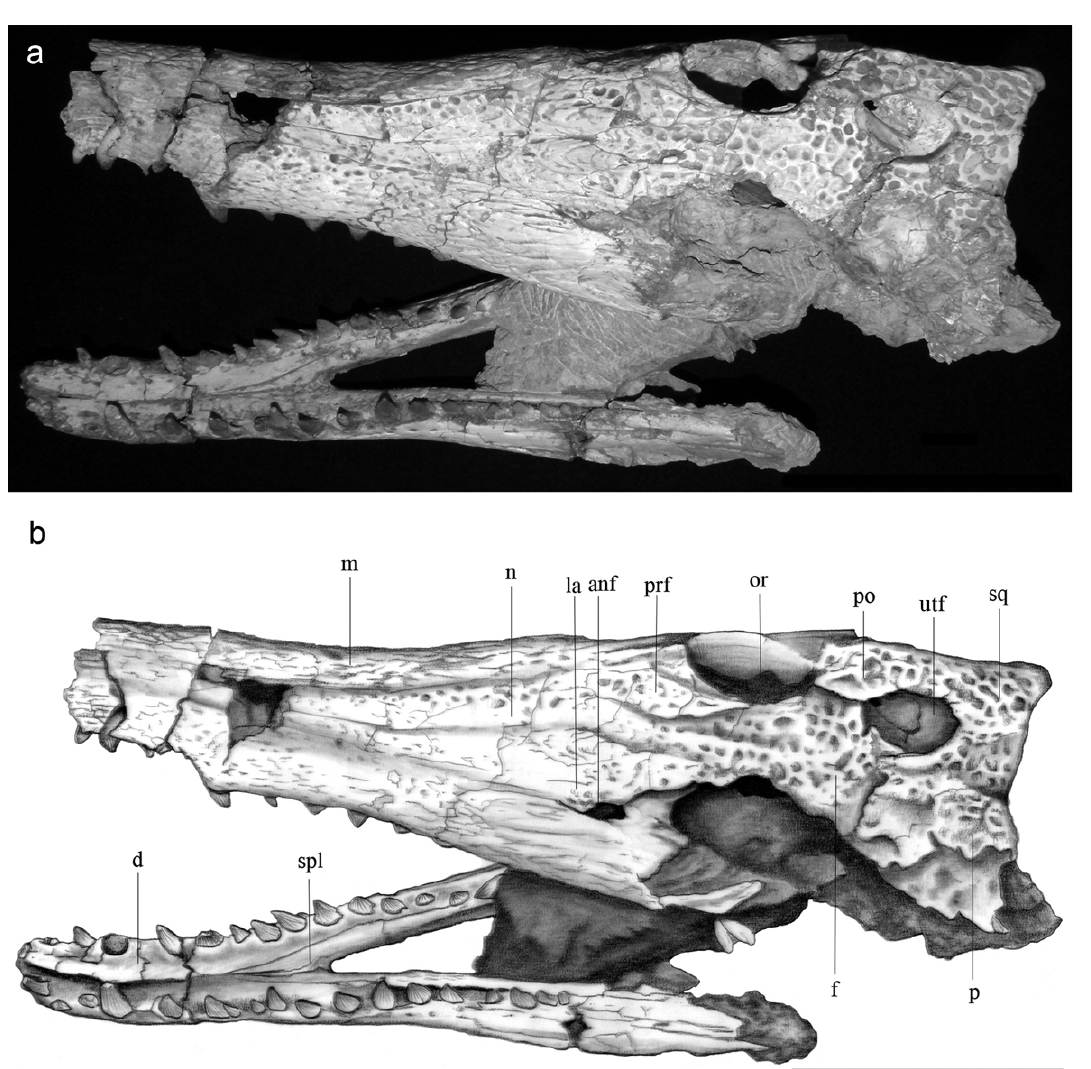
Fig. 1 – Dorsal view of skull and mandible of the holotype (MN 7005 – V) of the crocodyliform Pepesuchus deiseae gen. et sp. nov. Scale bar: 100 mm. Abbreviations: anf – antorbital fenestra, d – dentary, f – frontal, la – lacrimal, m – maxilla, n – nasal, or – orbit, p – parietal, po – postorbital, prf – prefrontal, spl – splenial, sq – squamosal, utf – upper temporal